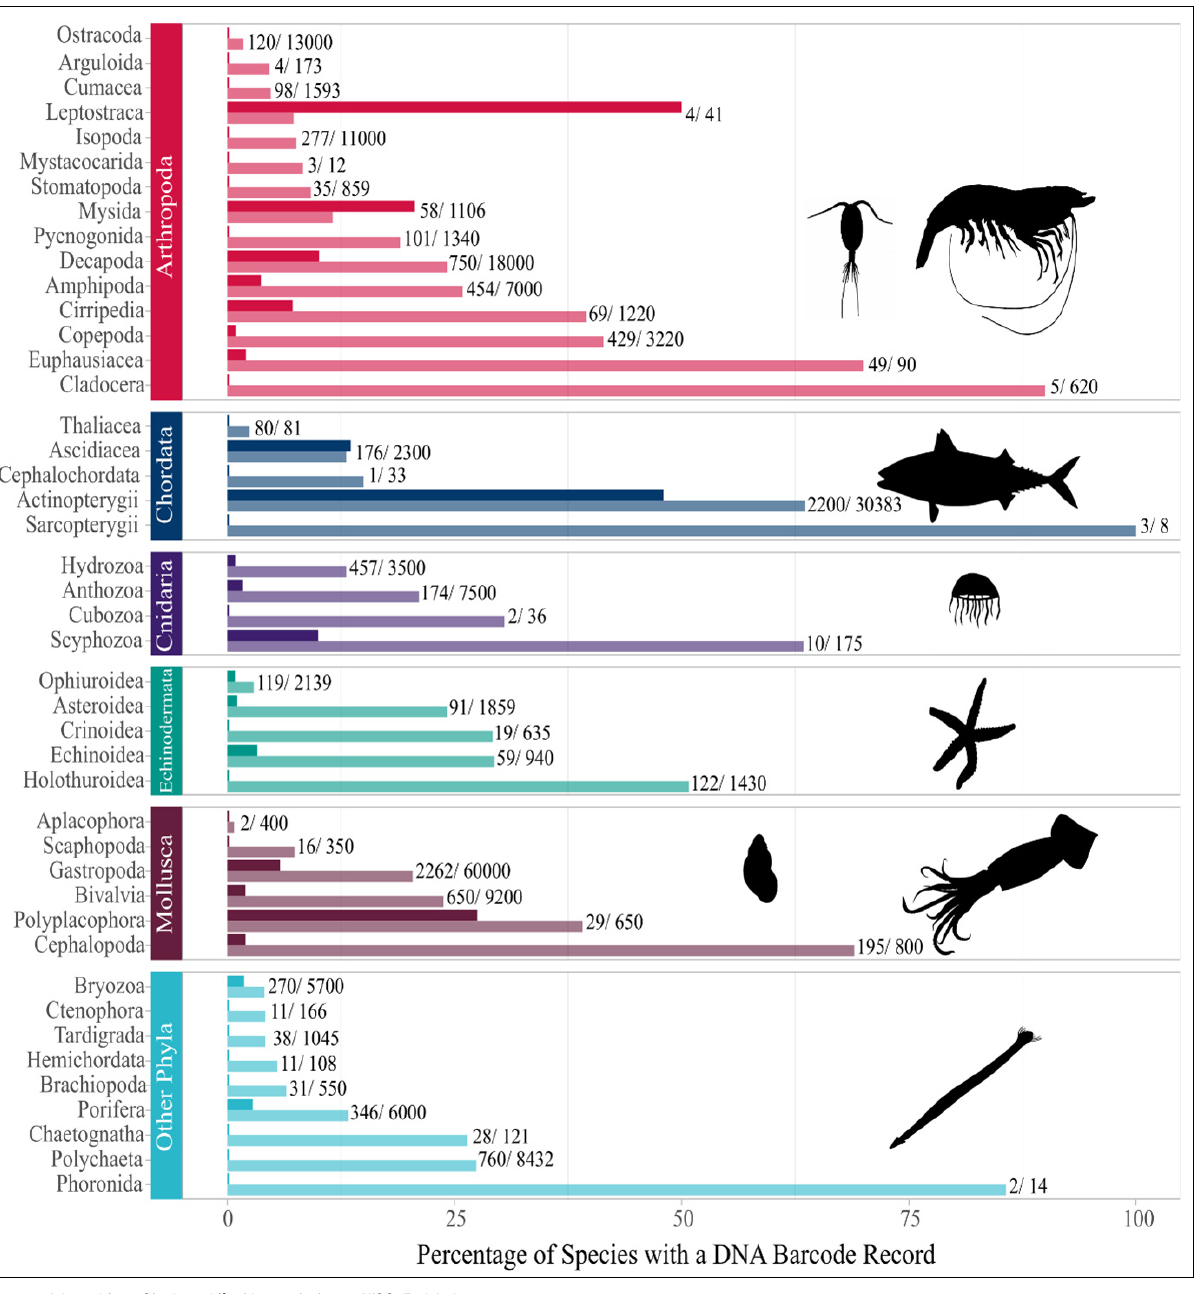
Figure 1: The relative percentages of DNA barcode records available for marine zooplankton taxa, globally (pale bars) and for South Africa (dark bars). Numbers next to the bars are the numbers of species known